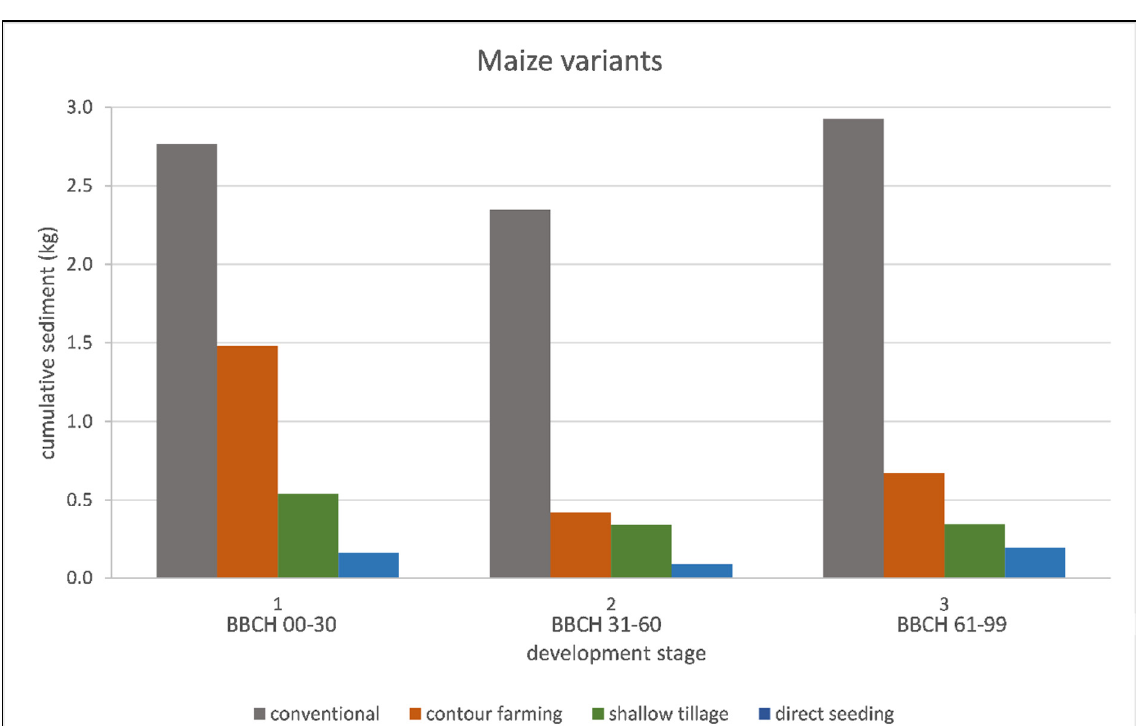
Figure 7. Transported sediment for different farming practices on maize, average of dry and wet conditions.